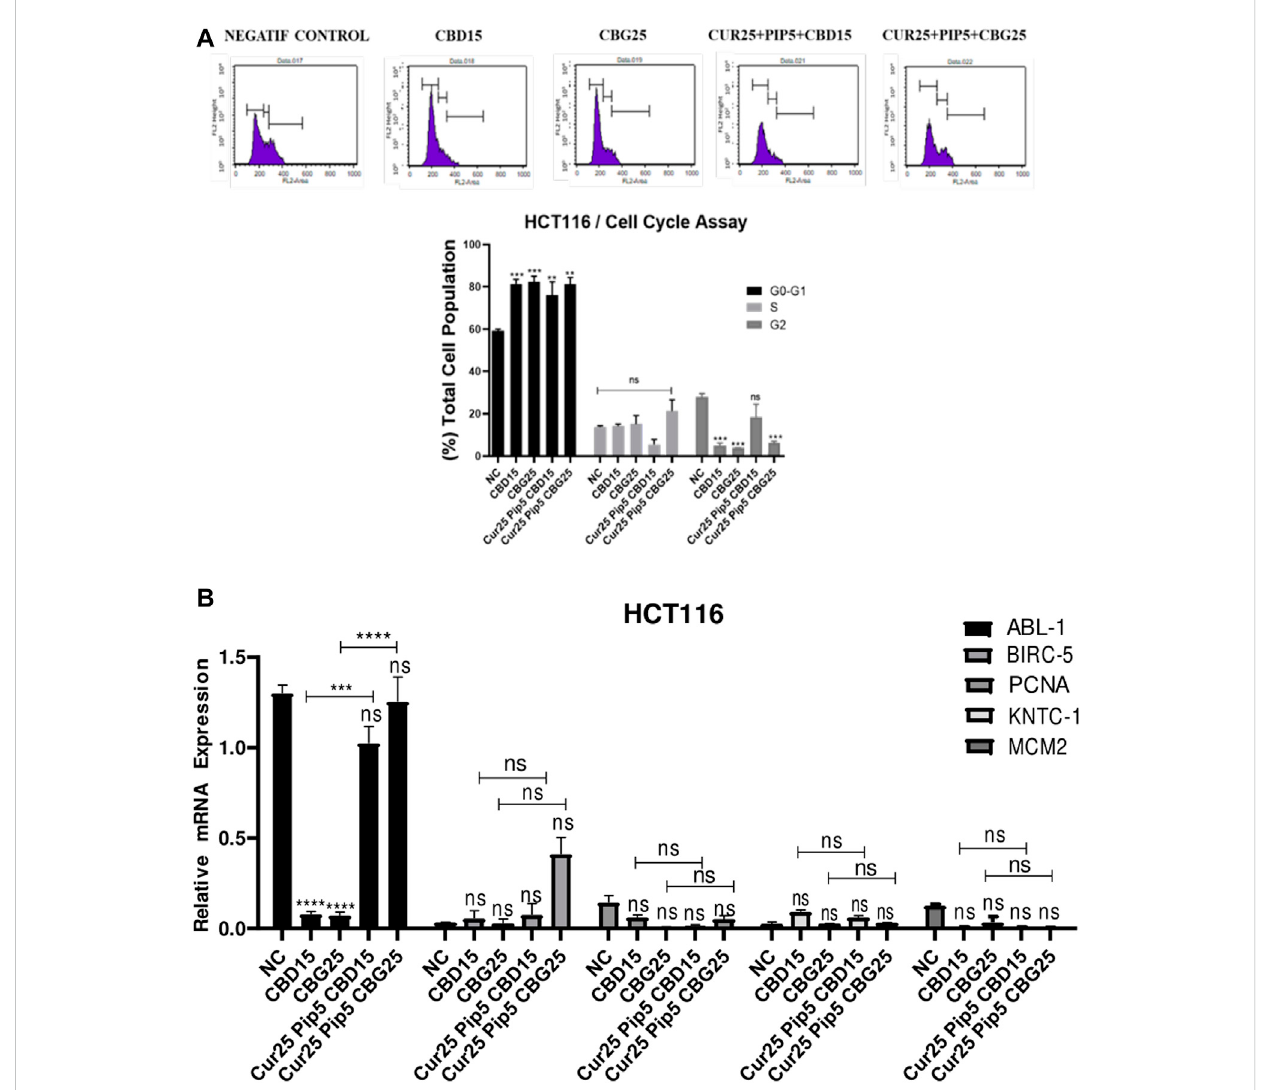
FIGURE 6 Distribution of cell cycle phases by fl ow cytometry for HCT116 cells (A) Distribution of cell cycle phases; the initial, middle, and last peaks show G0/ G1, S and G2 respectively and the result of cell cycle analysis percentage of HCT116 cells in G0/G1, S and G2 phase compared with negative control. (B) Representativegraphofcellcyclegenesexpressionpro fi lesofHCT116cellsafter72 h.(ns:non-signi fi cant,*: p < 0.05,**: p < 0.01,***: p < 0.001,****: p <